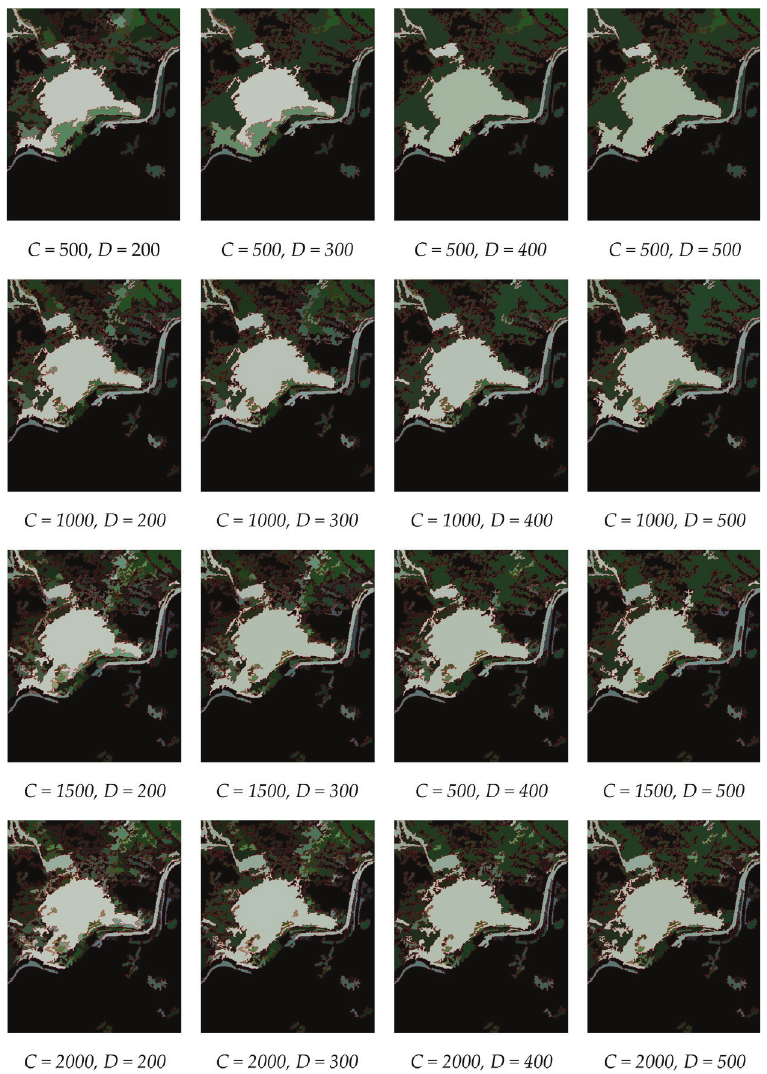
Figure 5. Segmentation results of the slope hazard boundary using the multiscale Luv-RMWS.